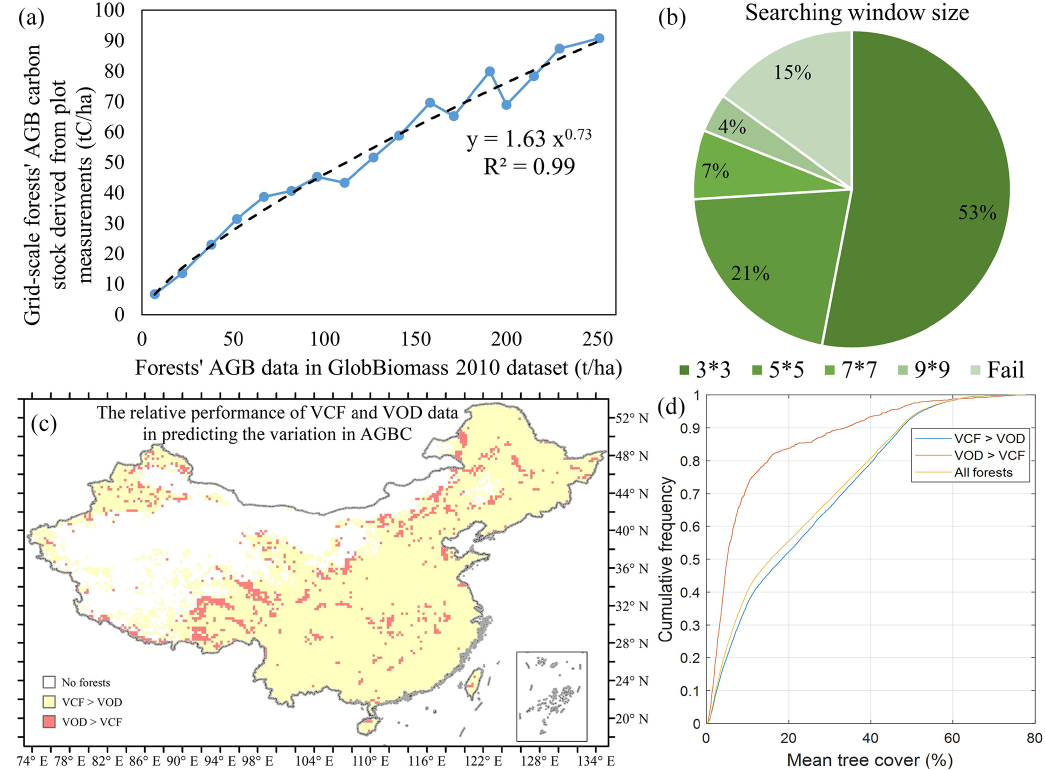
Figure 3. Evaluation of the forest AGBC and BGBC mapping in this study. (a) The regression relationship between the grid-scale forest AGB carbon stock derived from plot measurements during 2011–2015 and the GlobBiomass AGB dataset for 2010. (b) The minimum searching window sizes of every 1 / 120 ◦ grid when the spatial variation in MODIS VCF was applied as the predictor of AGBC changes. (c) The spatial pattern of the relative performances of MODIS VCF and LPDR VOD data in predicting the variation in AGBC. (d) Comparison of the mean tree cover between the grids where VOD data were more suitable for predicting the variation in AGBC and the grids where VCF data were the better predictor.